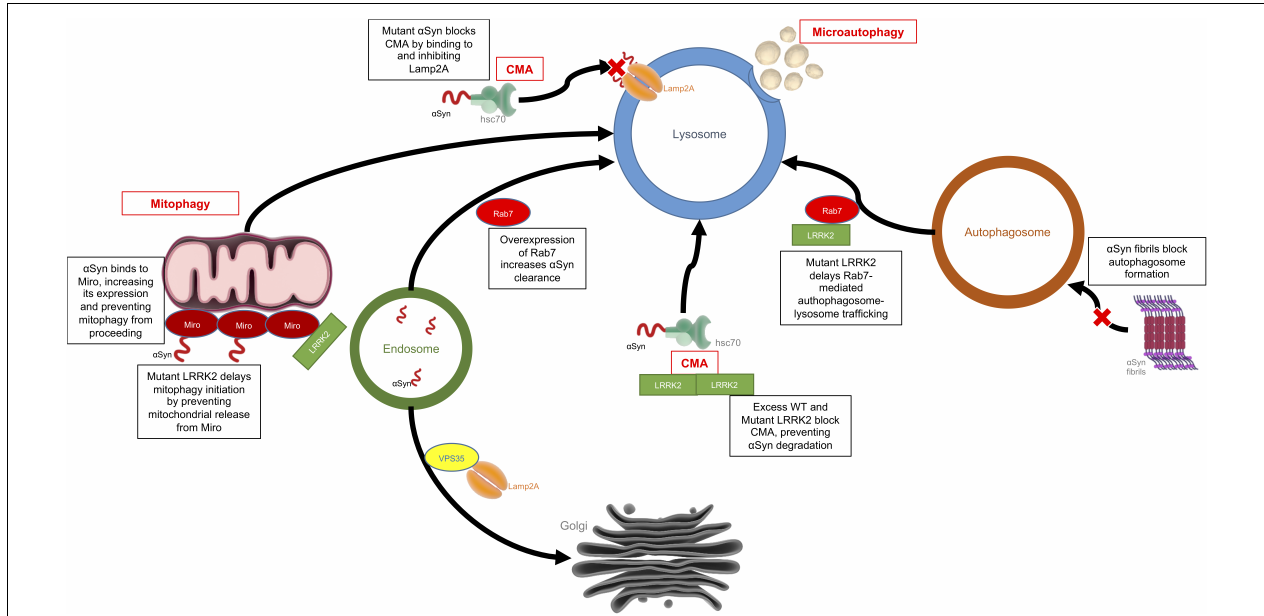
FIGURE 3 | Effects of LRRK2 and α -synuclein on the autophagy-lysosomal pathway. This is an example of how LRRK2 and α -synuclein can have convergent mechanisms with both affecting the autophagy-lysosomal system but each acting on different targets within the system. Mutant or aggregated α -synuclein can block CMA and autophagosome formation, while mutant LRRK2 can also block CMA, disrupt mitophagy or delay autophagosome